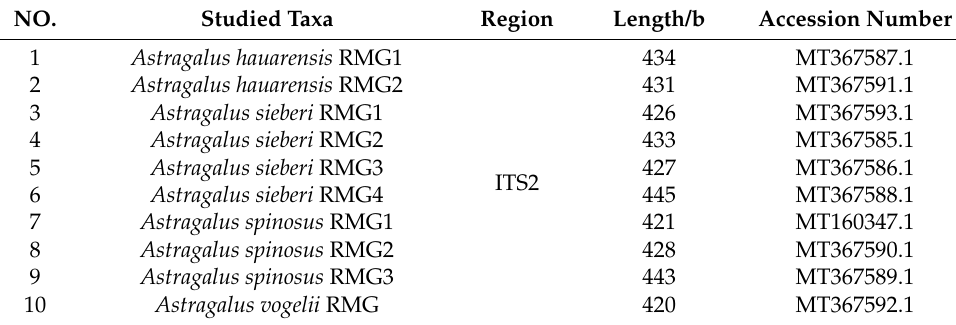
Table 6. The GenBank accession number of the submitted ITS2